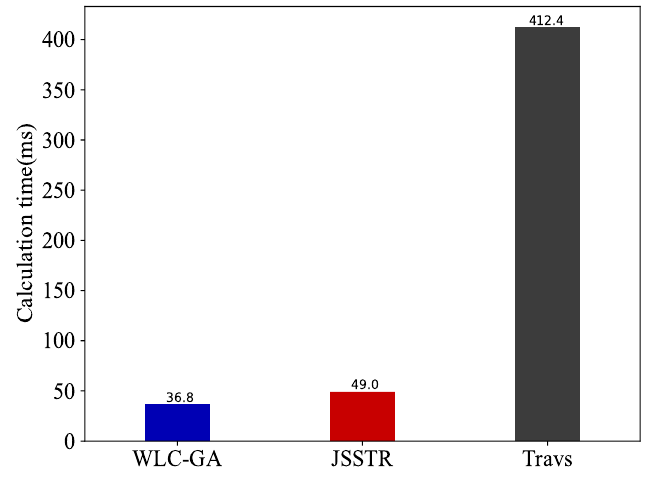
Figure 10. Calculation time comparison for JSSTR, Travs and